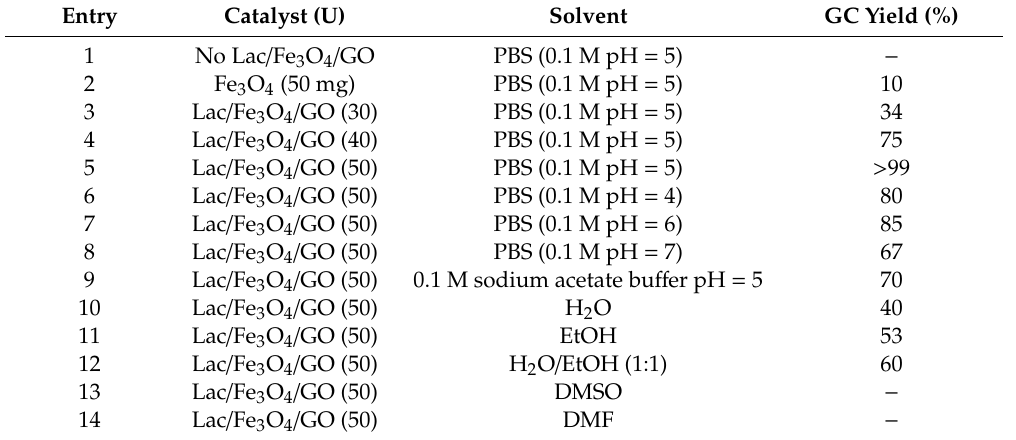
Table 2. Optimization experiments to investigate the e ff ect of the catalyst and solvent on the synthesis of